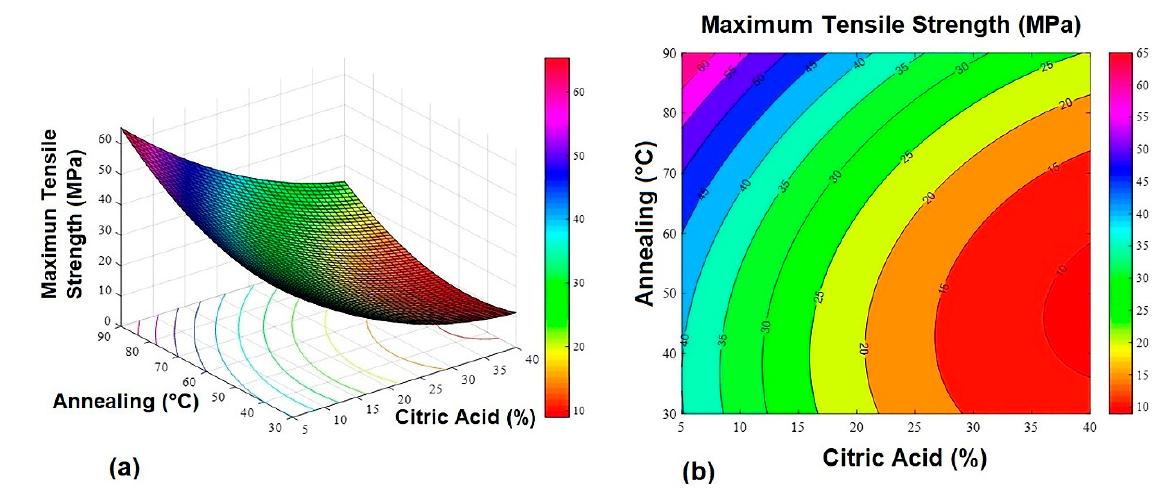
Figure 1. Maximum tensile strength response surface graphs. ( a ) 3D response surface graph and ( b ) contour plot.